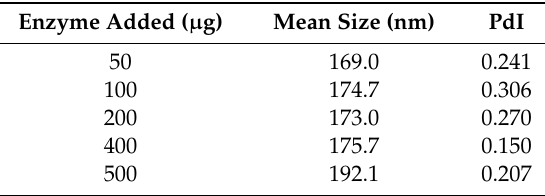
Table 3. Influence of the quantity of elosulfase alfa added to the preparation media on the size of the NLCs.